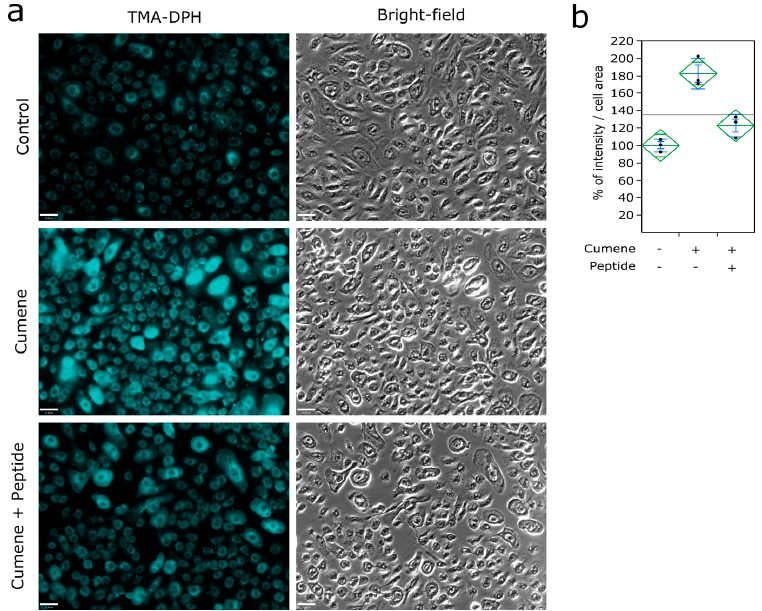
Figure 7. Ubiad1 preserve keratinocyte plasma membrane mechanical properties. ( a ) Plasma membrane integrity measurement with trimethylamine-diphenylhexatriene (TMA-DPH) probe (blue) in keratinocyte exposed 1 h to 2 mM cumene hydroperoxide (×20 objective lens, scale bar = 31 µm); ( b ) TMA-DPH quantification graph with One-Way Analysis of Variance, displaying confidence interval means diamonds (green). The line across each diamond represents the group mean. The vertical span of each diamond represents the 95% confidence interval for each group. Grand sample mean is represented by a horizontal black line.